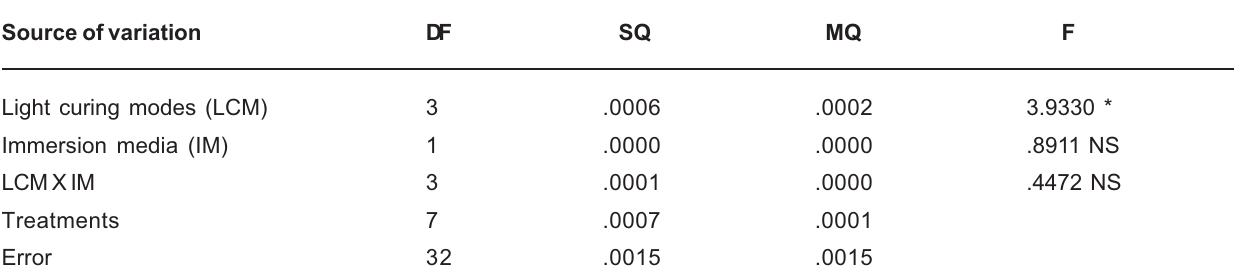
DF – degree of freedom; SQ – Sum of squares; MQ – Mean square; * - statistically significant difference; NS - no statistically significant